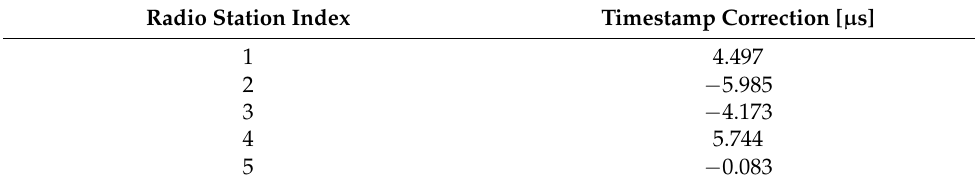
Table 3. Assigned values of timestamp correction for radio